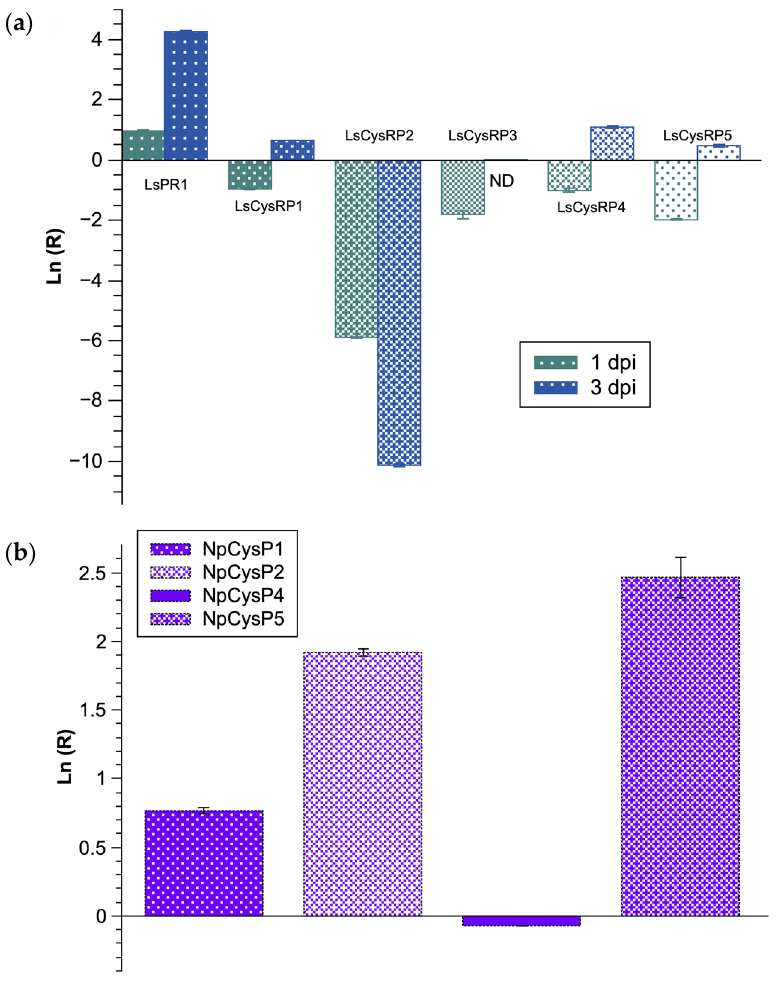
Figure 8. Expression in the early stages of infection of CysRP mRNAs of both L. styraciflua and N. parvum . ( a ) LsCysRP mRNA expression at 1 and 3 dpi, RNA was extracted from leaves with mechanically injury and used as a control. The geometric mean between Tip41 and actin was used as a reference. For all of the transcript statistics, significant differences were detected between 1 and 3 dpi at p < 0.01 using Student’s t test. ( b ) NpCysRP mRNA expression at 3 dpi, 1 dpi was used as control. For the analysis, NpCysRP3 was used as a reference gene. The data are the average of three independent inoculation